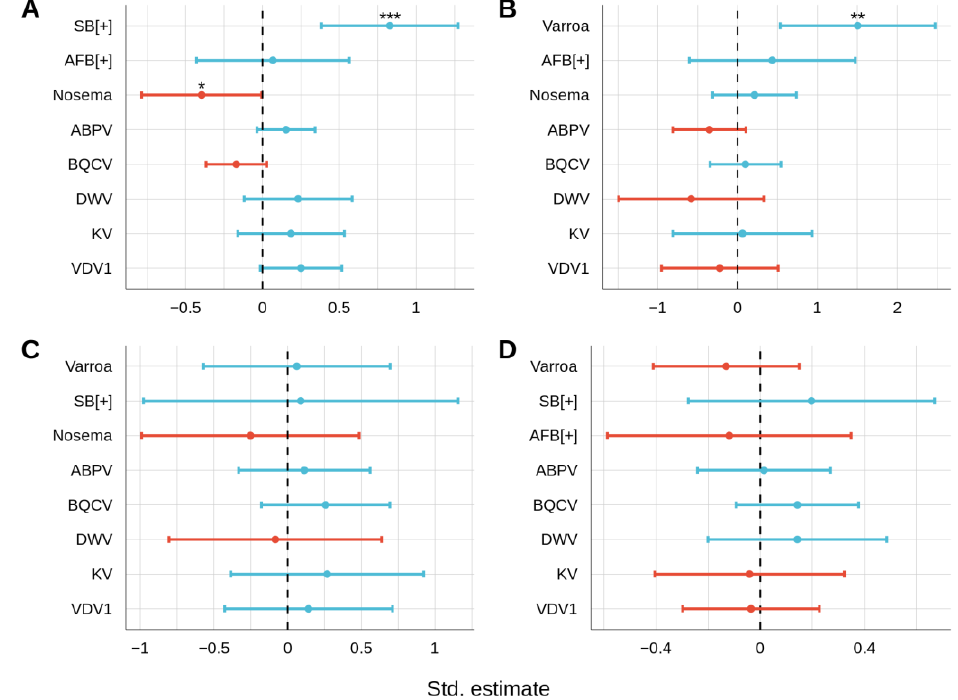
Figure 5. Standardized estimates from the GLMM analysis of Varroa mites ( A ), SB (SB) ( B ), American foulbrood (AFB) ( C ), and N. ceranae ( D ). Green lines indicate 95% confidence intervals that have an overall positive relationship while red lines indicate a negative relationship. * p < 0.05, ** p < 0.01 and *** p < 0.001.